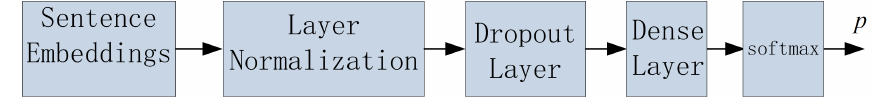
Figure 7. The architecture of MLP for probing